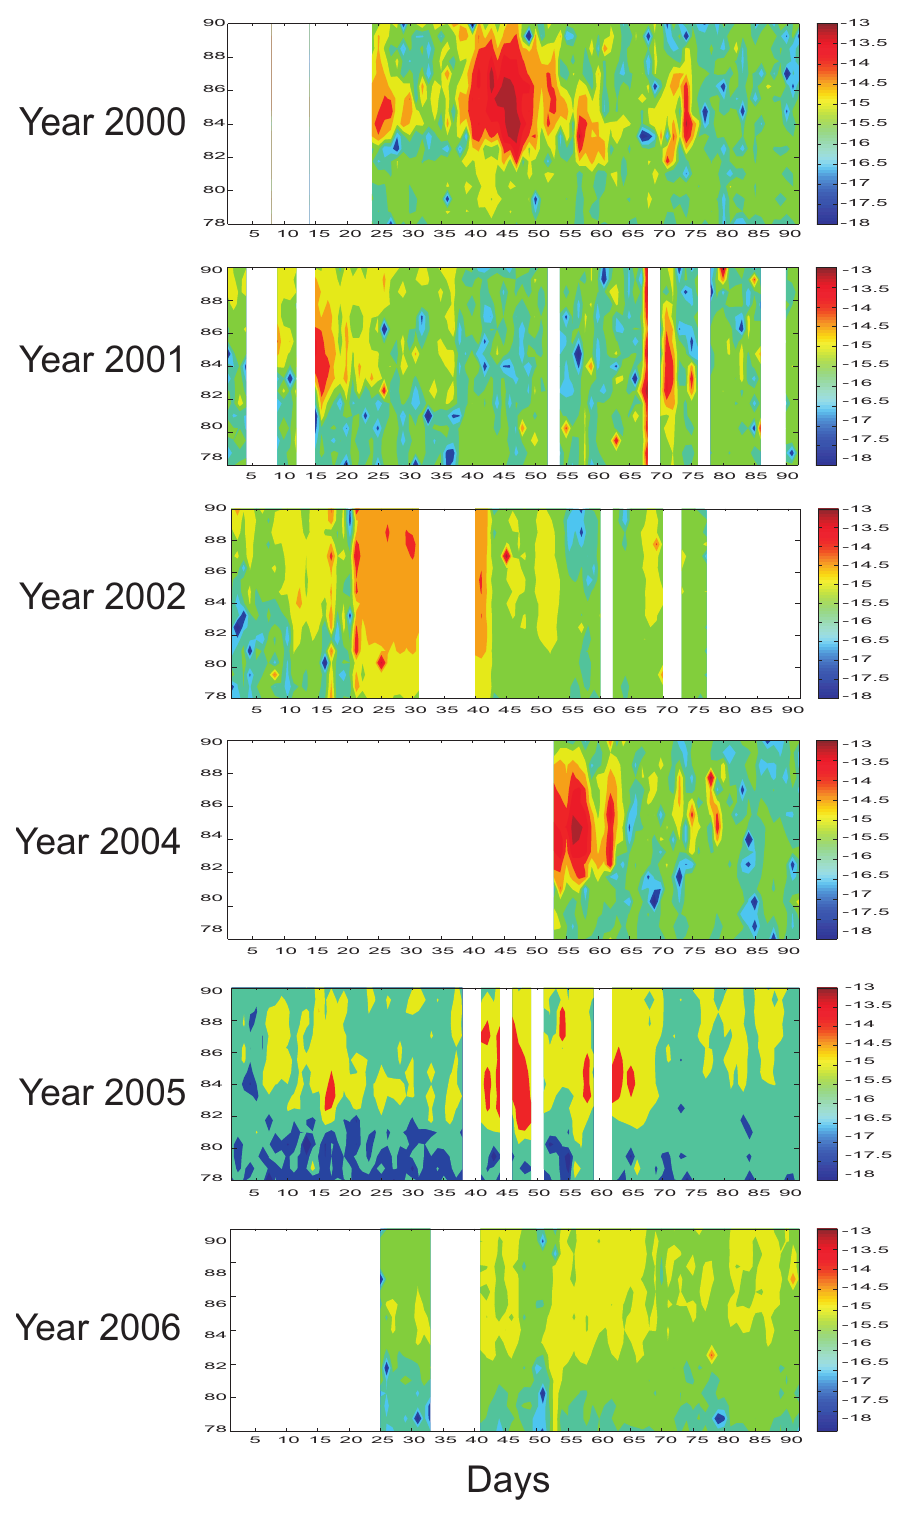
Fig. 4. Long term PMSE seasonal variation observed at Resolute Bay for the interval year 2000–2006 (except 2003). For each year, data for the months June, July and August are shown. The daily mean backscatter cross-section values are plotted using natural logarithmic scale for height region 80–90km. The gaps refer to missing